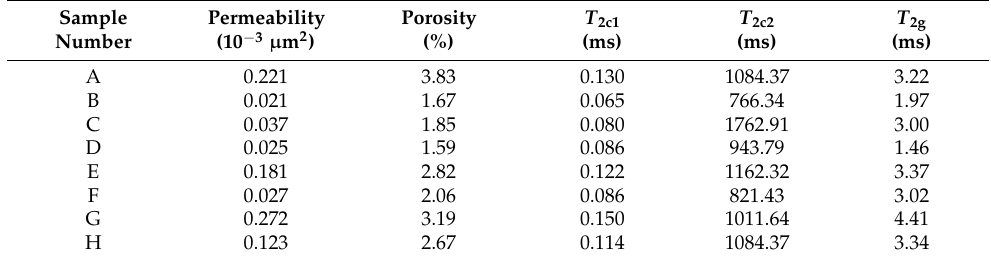
Table 1. Petrophysical properties of coal samples in the experiment.